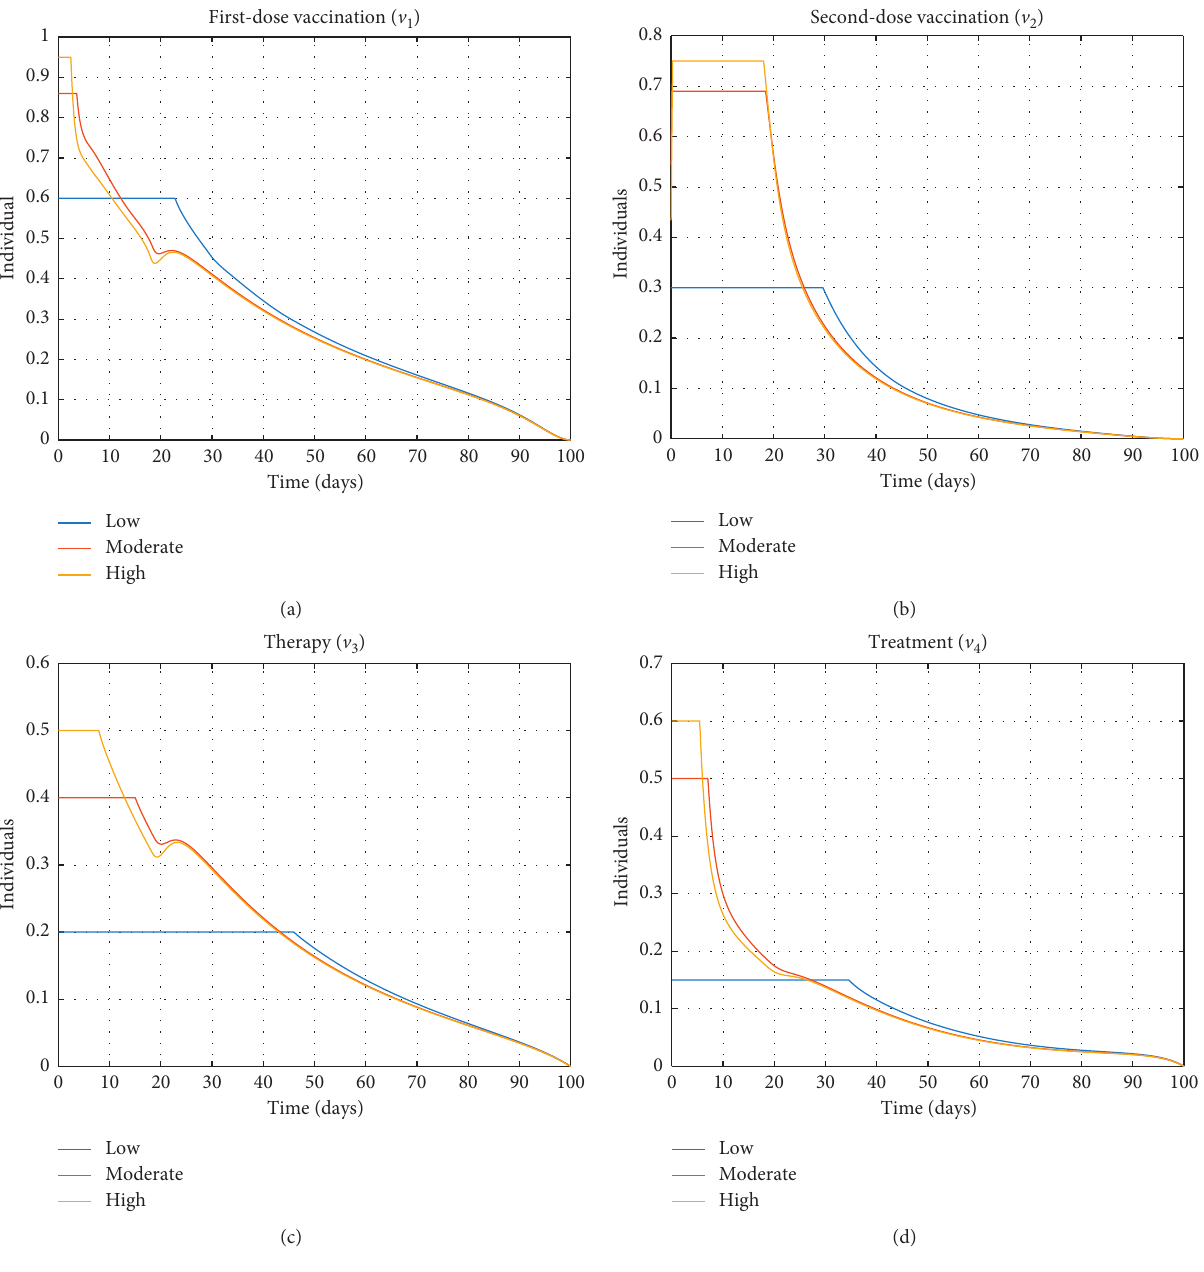
Figure 7: The optimal controls using different